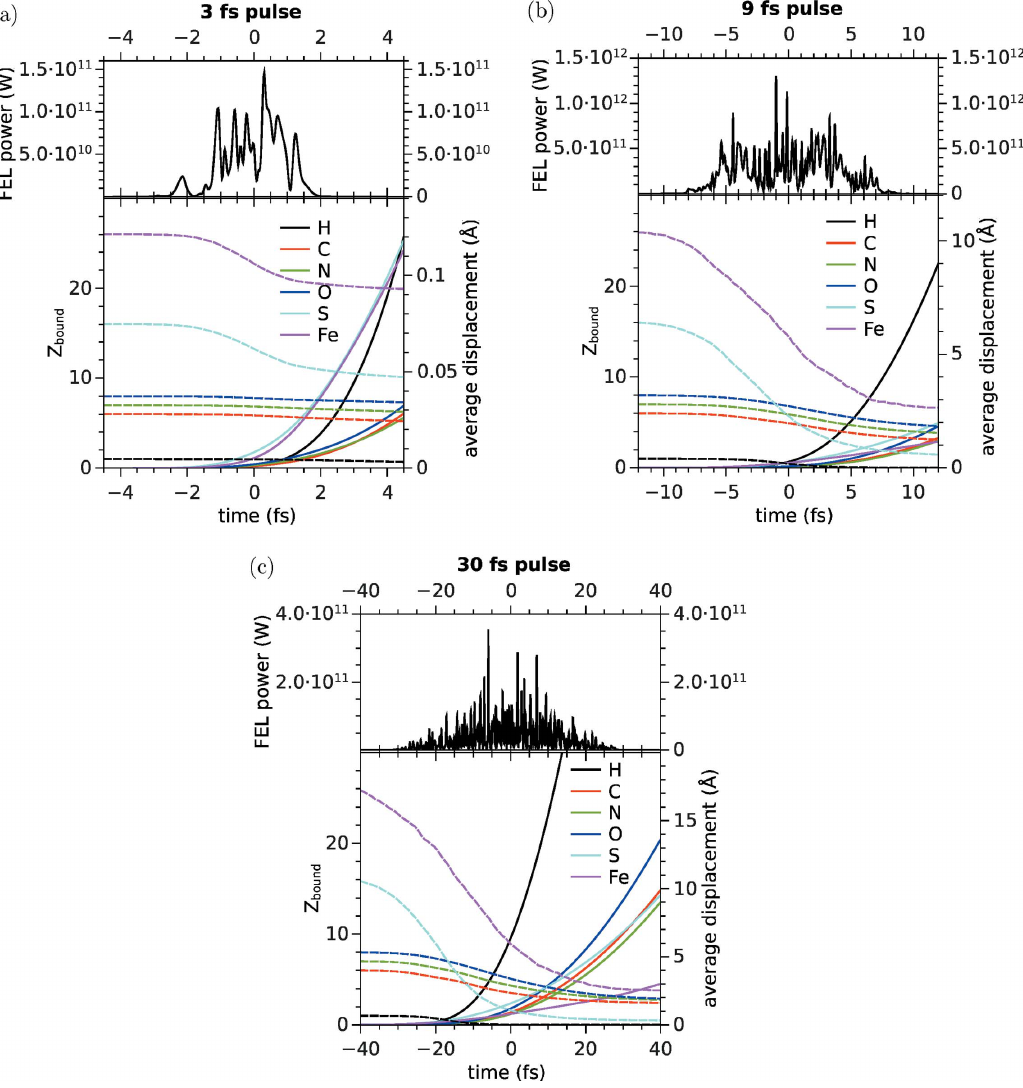
Figure 1 The temporal structure of the simulated X-ray pulse, the average number of bound electrons ( Z bound , dashed curves) and the average atomic displacements (solid curves) in the 2nip sample as a function of time for pulse durations of ( a ) 3 fs, ( b ) 9 fs and ( c ) 30